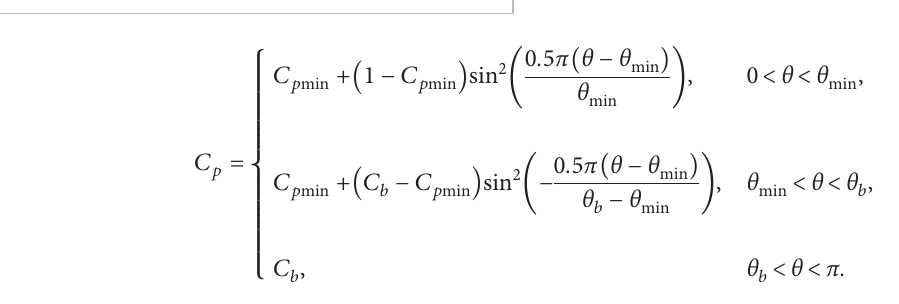
Figure 18: Fitting results of the shape coefficient at different test conditions (a) c � 0 . 0386 and (b) c � 0 .